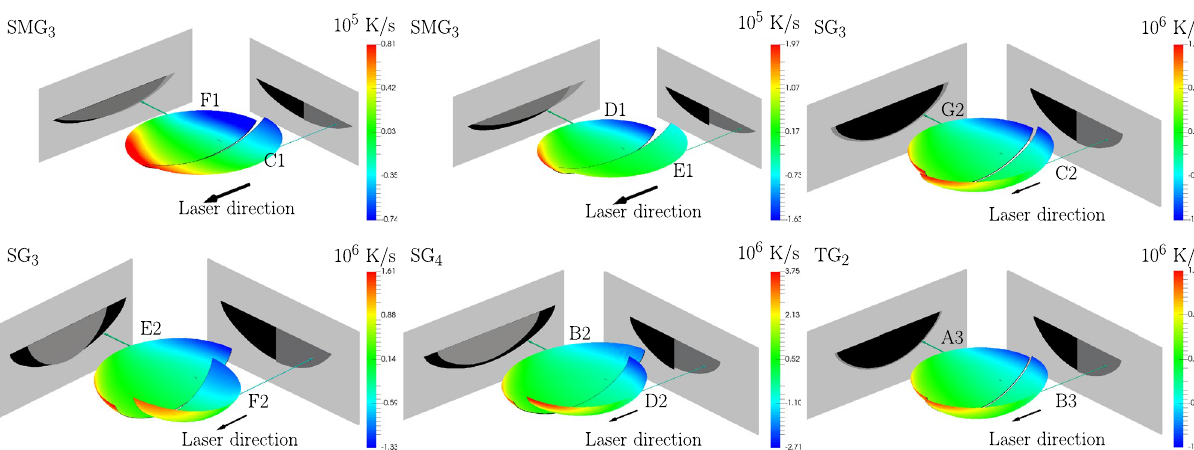
Figure 4. Comparison of melt pools computed by the models. The melt pools are projected onto planes ˙ T perpendicular and parallel to the laser velocity. The contours are cooling rates . The left column shows comparisons between the convective and conductive models for the optimal ( α , z S ) pairs in Table 1 for the SMG 3 and SG 3 cases. The middle column shows a comparison between convective models with (α , z S ) values at opposite extremes of the ranges for the SMG 3 and SG 4 cases. The right column shows a comparison between convective models with (α , z S ) values at opposite extremes of the grayed regions for the SG 3 and TG 2 cases. In each case, the melt pool traces of the two melt pools are very close to the experimental